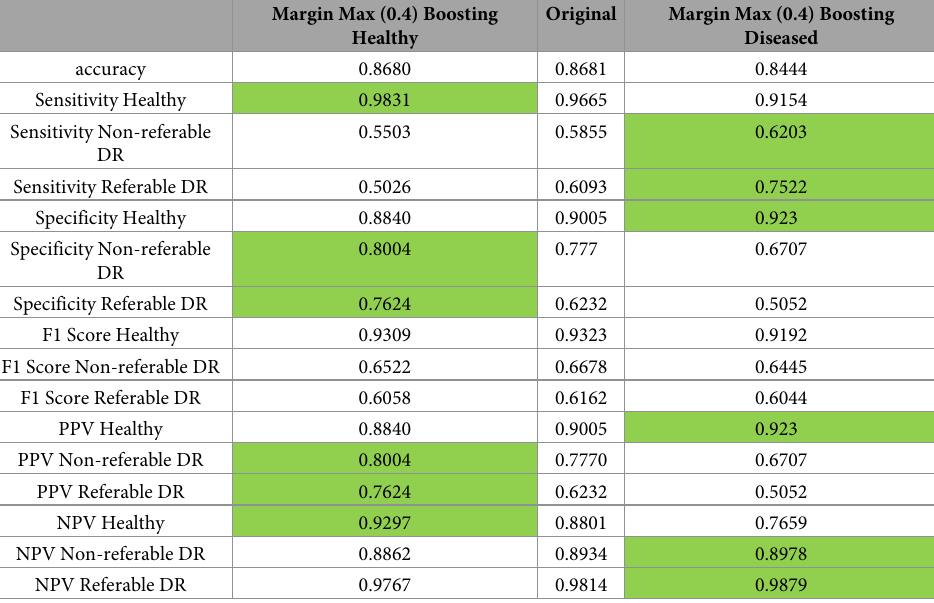
Table 6. Sensitivity boost of the ‘un-curated’ dataset with three labels, for healthy and diseased